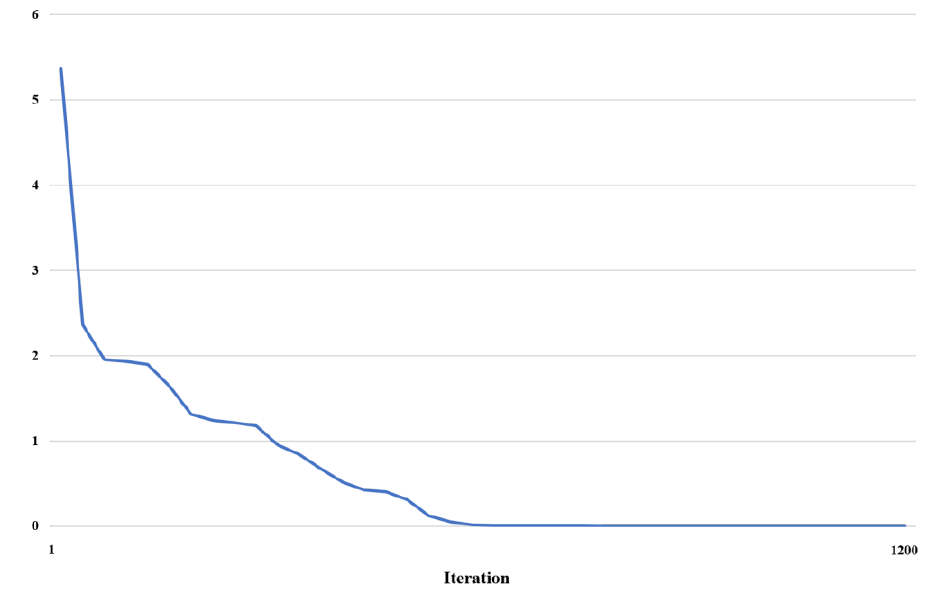
Figure 16. Losses by iteration.